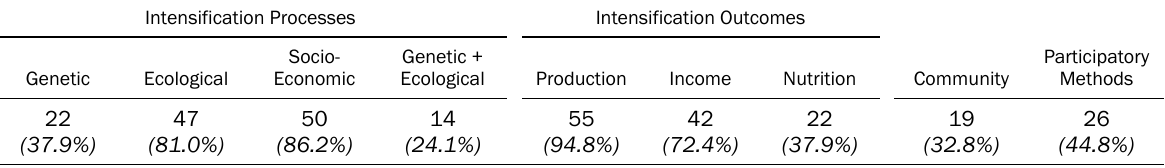
Table 1. Frequency of Intensification Processes and Outcomes in